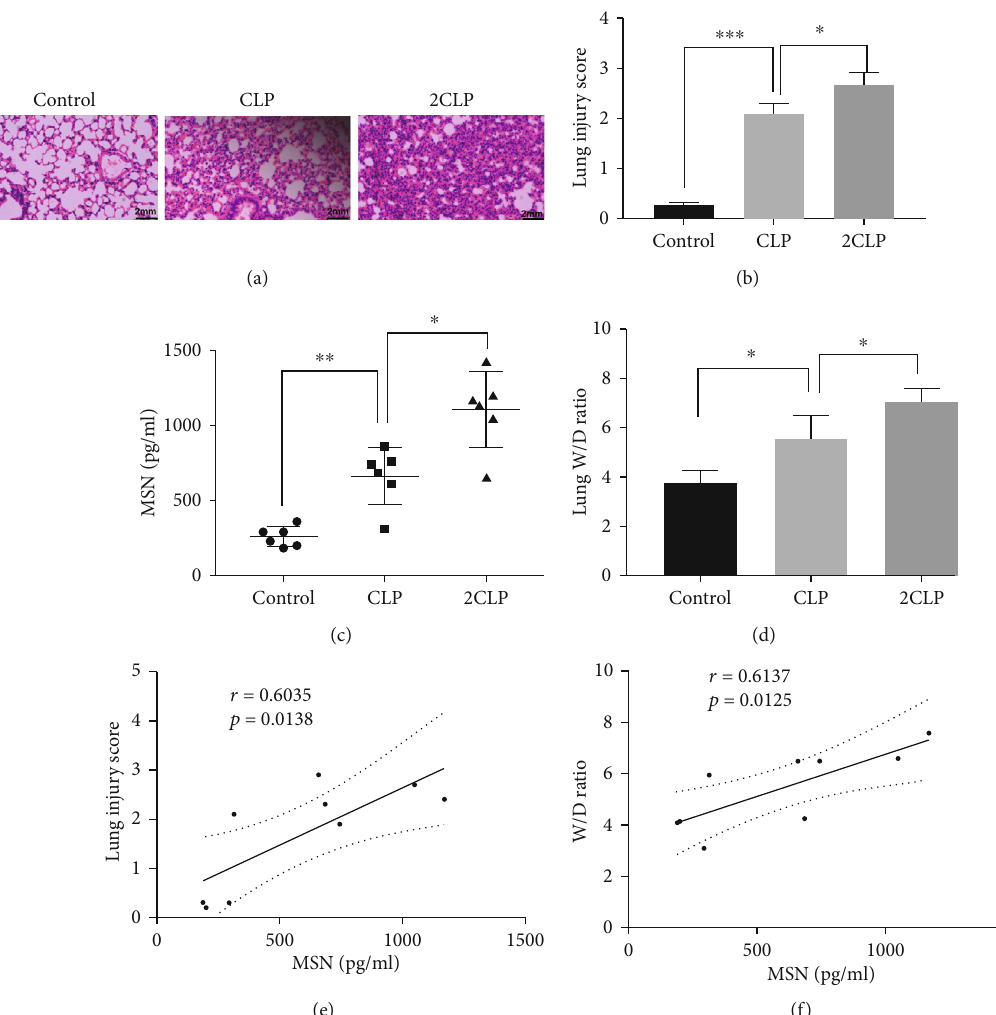
Figure 3: CLP surgery increased the MSN expression and lung injury in mice. Sublethal and lethal CLP were used to construct the septic mouse model, and their serum MSN levels were examined by ELISA, 24h after CLP surgery. (a) H&E staining of lung tissue sections in di ff erent groups of mice (magni fi cation × 100). (b) Lung injury scores. (c) Serum MSN levels in di ff erent groups of mice. (d) The W/D ratios in di ff erent groups of mice. The correlation between serum MSN and lung injury scores (e), serum MSN levels, and lung W/D ratios (f). NS: not signi fi cant, ∗ p < 0 : 05 , ∗∗ p < 0 : 01 , ∗∗∗ p < 0 : 001